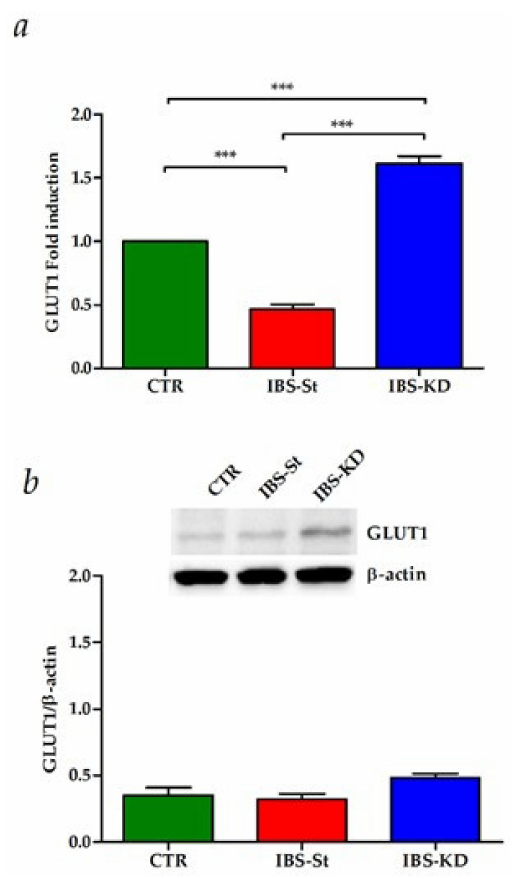
Figure 4. ( a ) GLUT1 gene expression levels in the control group (CTR), IBS rats fed a standard diet (IBS-St), and IBS rats treated with low-carbohydrate, high-fat ketogenic diet (IBS-KD); ( b ) GLUT1 protein expression levels and representative blots in the control group (CTR), IBS rats fed a standard diet (IBS-St), and IBS rats treated with low-carbohydrate, high-fat ketogenic diet (IBS-KD). All data represent the results of three different experiments (mean ± SD). p -value was determined by ANOVA with Tukey’s multiple comparison test; *** p <